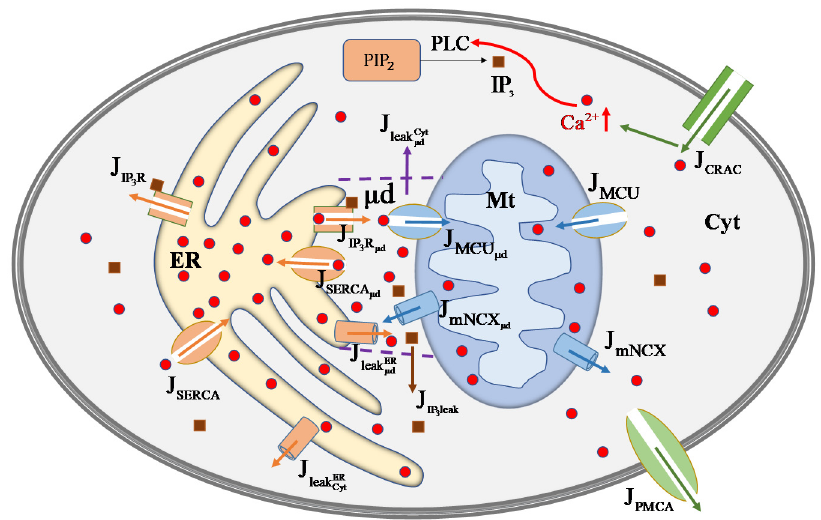
Figure 1. Schematic diagram of the regulation mechanism of cellular calcium concentration. After stimulation, Ca 2 + enters the mast cell through the Ca 2 + release-activated Ca 2 + (CARC) channels on Mem and increases [ Ca 2 + ] . Then PIP 2 is catalyzed by PLC to produce IP 3 . IP 3 binds to IP 3 R Cyt to activate Ca 2 + releases from ER. Endoplasmic reticulum Ca 2 + -ATPase (SERCA) pump uptakes Ca 2 + to ER. Ca 2 + leaks from ER by leak channel. Mt uptakes Ca 2 + through the MCU channel and extrudes Ca 2 + via the mitochondrial Na + /Ca 2 + exchanger (mNCX). These Ca 2 + channels in ER and Mt can face either Cyt or µ d. Ca 2 + and IP 3 can diffuse between Cyt and µ d. Ca 2 + is extruded from Cyt to extracellular matrix through the plasma membrane Ca 2 + -ATPase (PMCA) channels. J means calcium fluxes, such as J IP means the Ca 2 + outflux of IP 3 R